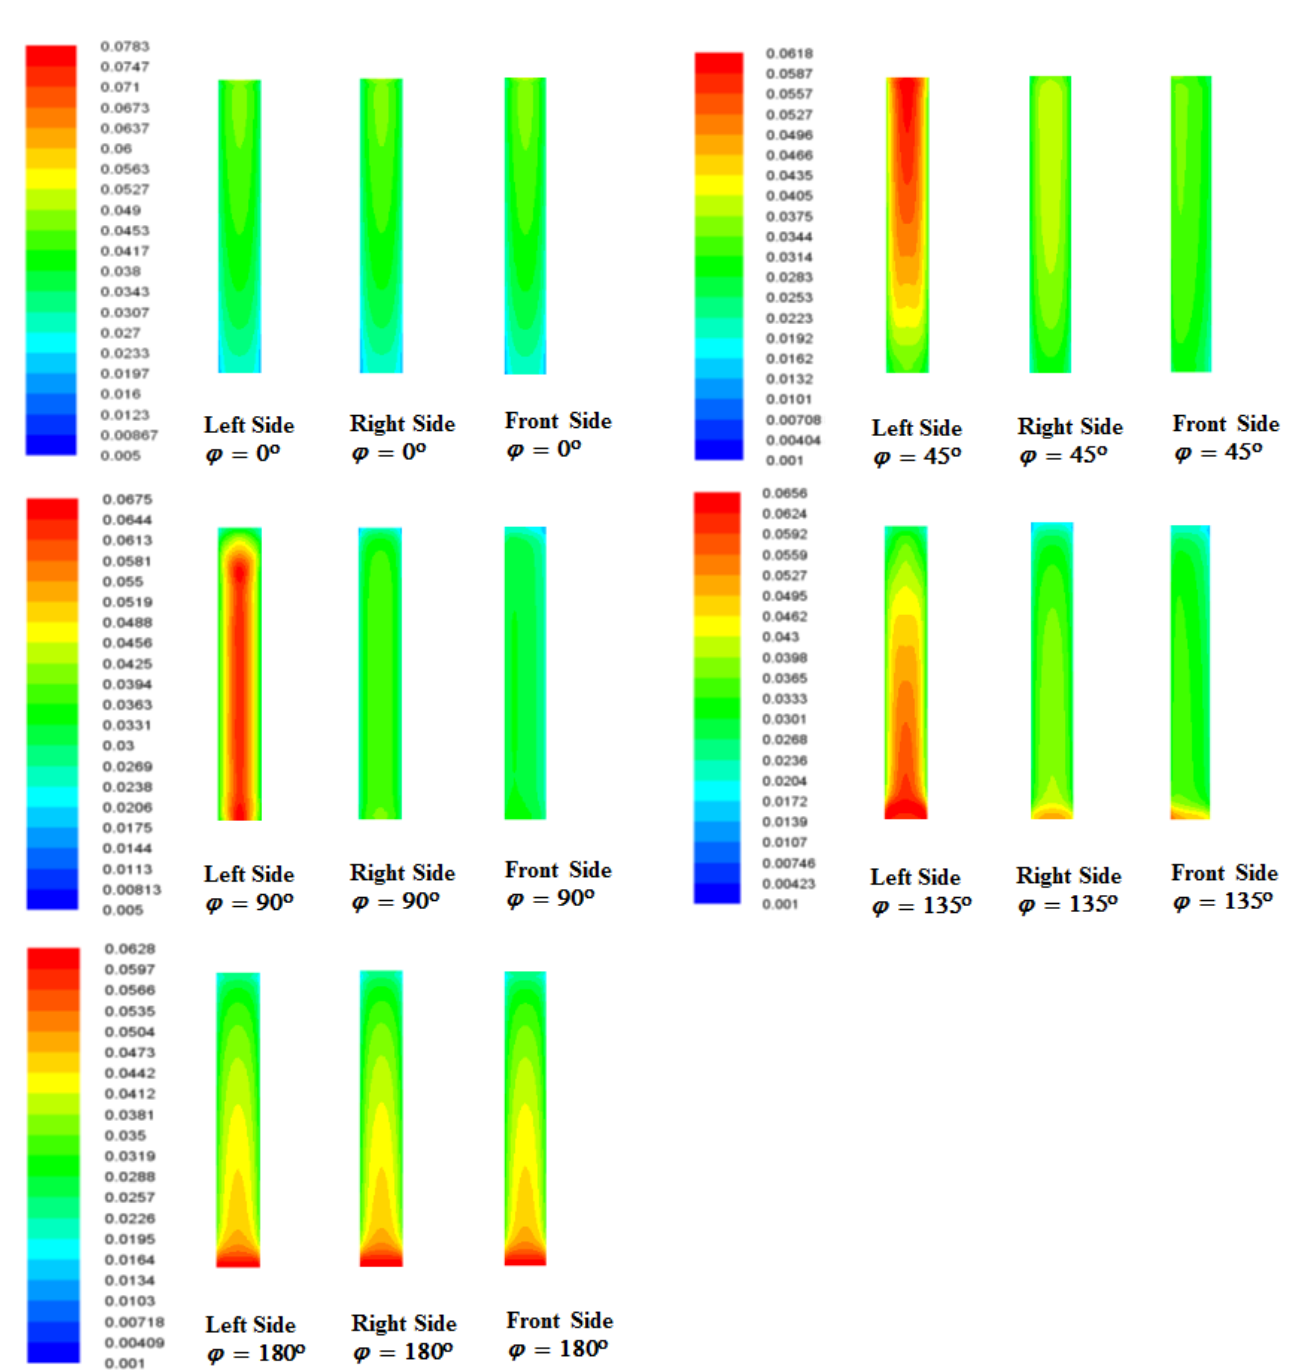
Figure 17. Variations in temperature distribution over the left-side, right-side, and front surfaces of the slender cuboid at different positions, ϕ , when Ra * = 1 × 10 8 and W = 0.15.